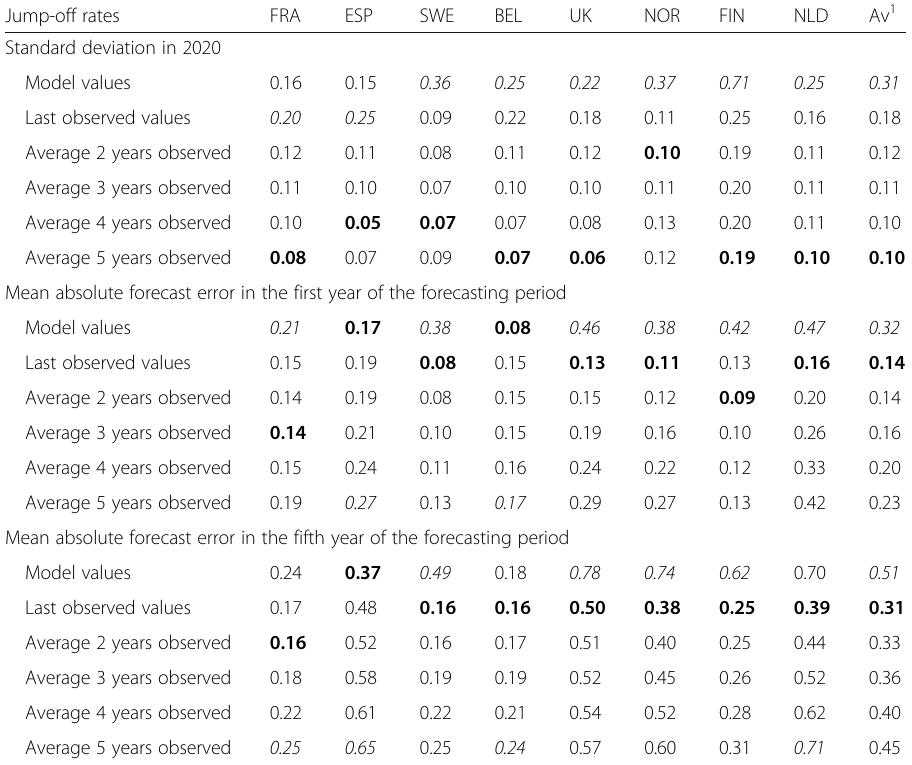
Table 10 Mean absolute forecast error (MAFE) of remaining life expectancy at birth for the first and fifth year in the forecasting period, and standard deviation (SD) of the increase/decrease of the life expectancy at birth in 2020 between ten successive forecasts, for six different choices of the jump-off rates applied to a Lee-Carter model, for eight countries, men and women combined, fitting periods 1960 – 2005, 1960 – 2006, … , 1960 – 2014